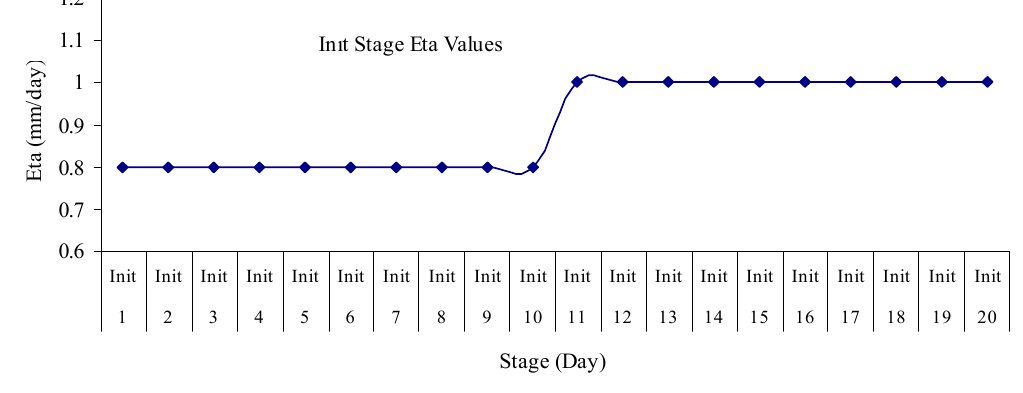
Figure 12. Int. Stage water requirement.